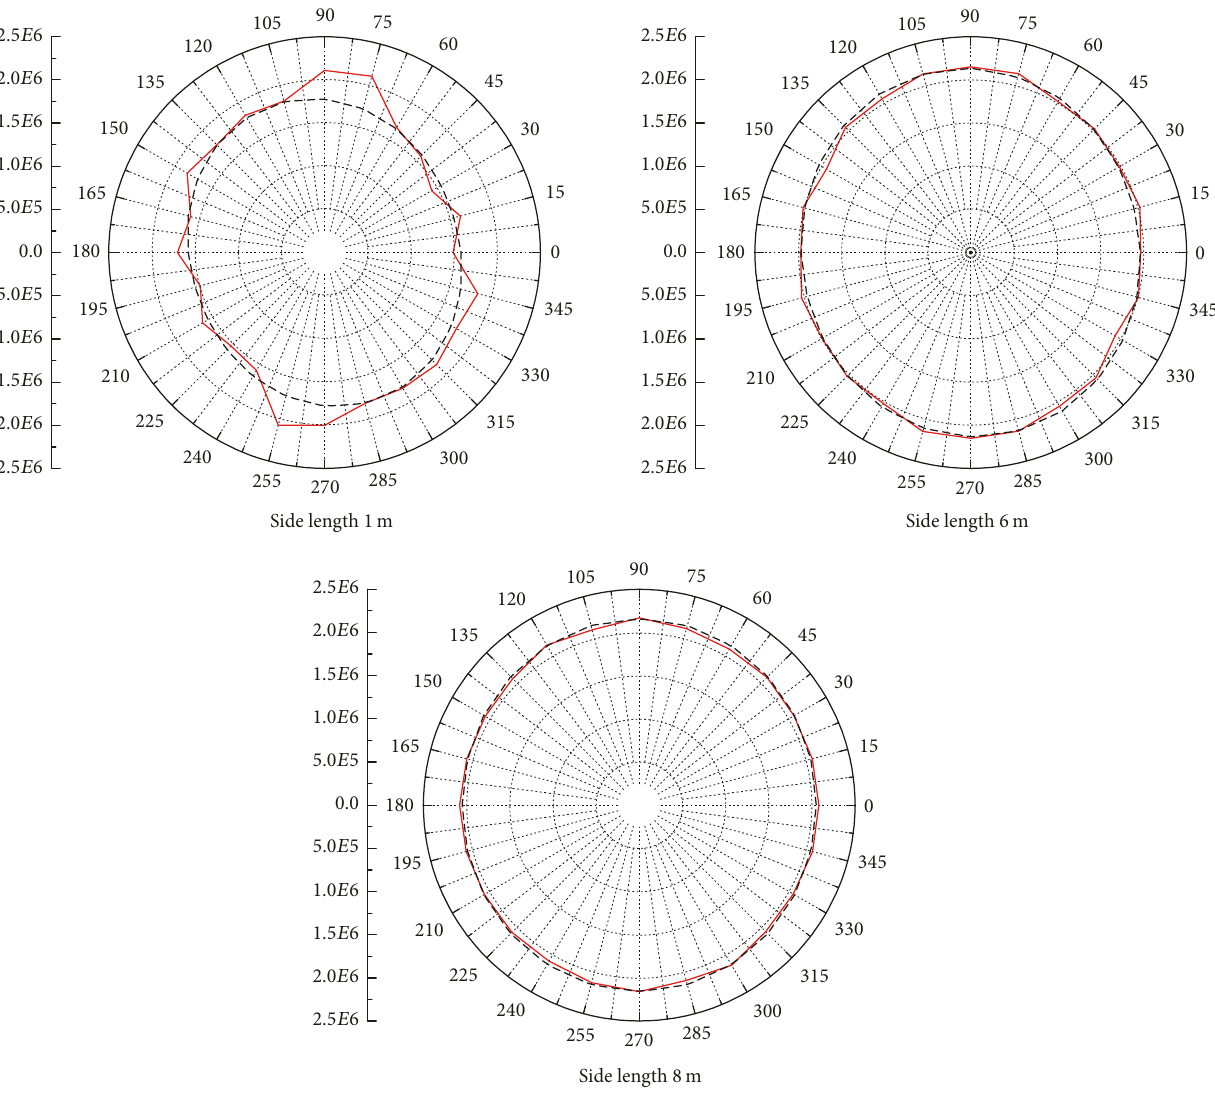
Figure 28: The equivalent intrinsic permeability ellipse with the increasing model size in the non-Darcy flow.